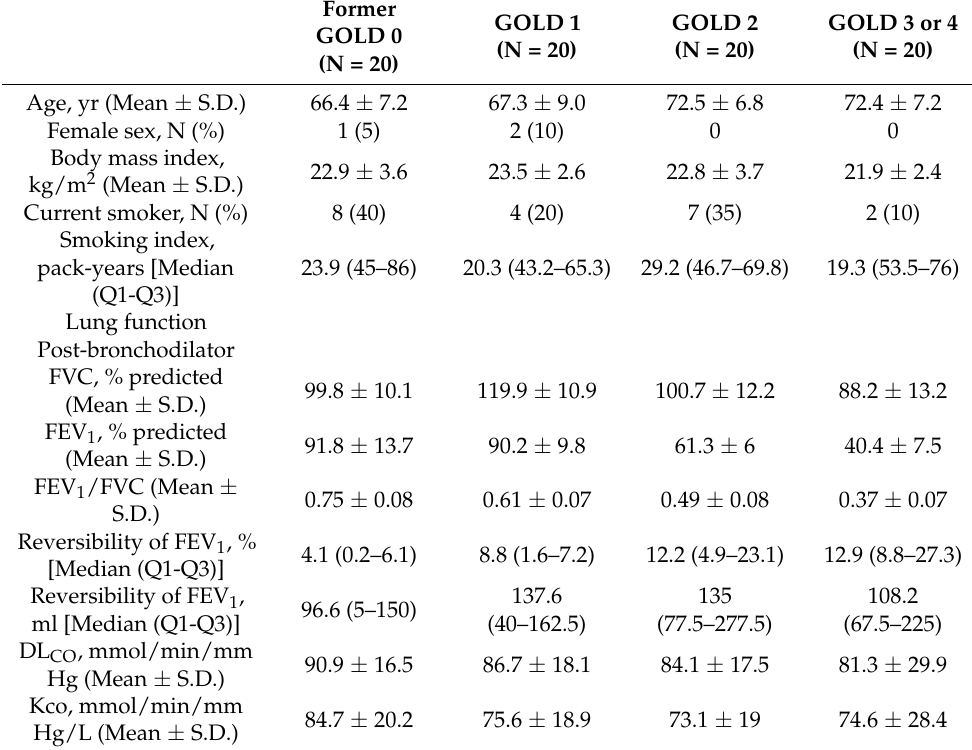
Table 1. Characteristics of subjects.